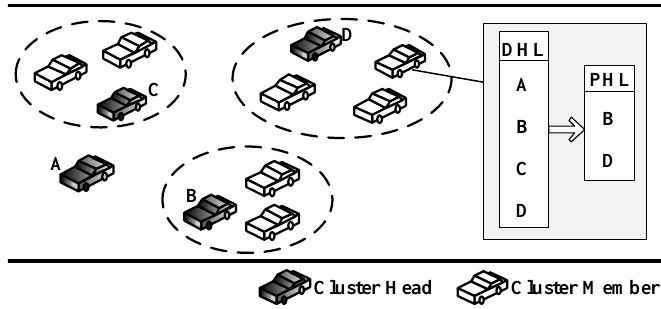
Figure 3. Example to save computational